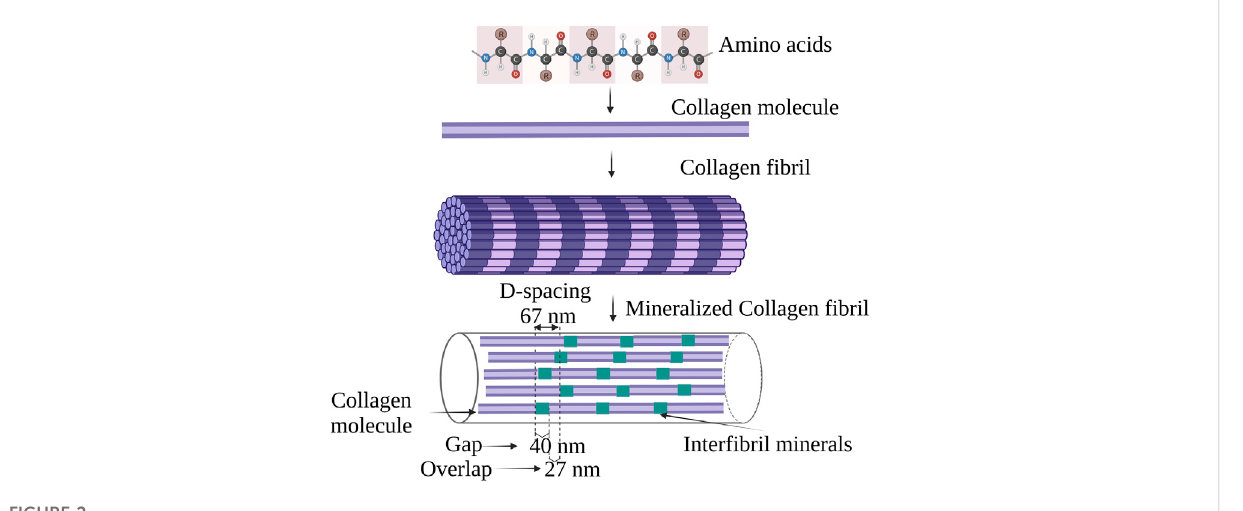
FIGURE 2 Schematic illustration of the hierarchical structure of